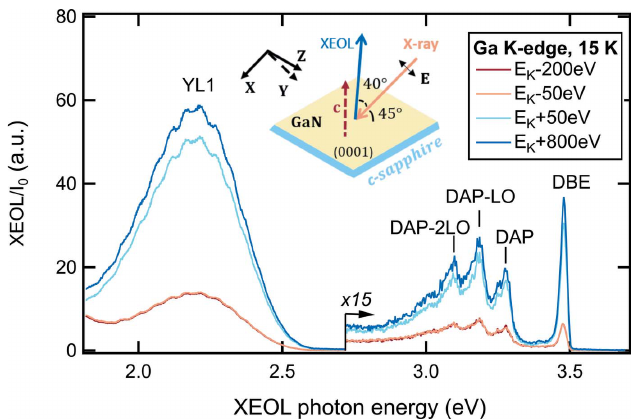
Figure 4 Normalized XEOL spectra measured at several selected X-ray energies across the Ga K -edge ( E K = 10367 eV) at 15 K on a single-crystalline GaN-(0001) thin film grown on crystalline sapphire substrate. The inset schematically illustrates the sample orientation relative to the polariza- tion vector E of the incident X-ray beam and the direction of the collected XEOL signal. Note that the measurement geometry corre- sponds to the mixed polarization case as the incidence angle of the linearly polarized X-ray beam is 45 (cid:4) with respect to the crystal axis c . The emission bands are labeled based on PL studies (Reshchikov, 2021; Reshchikov et al. , 2018), with the definition of the abbreviations given in Section